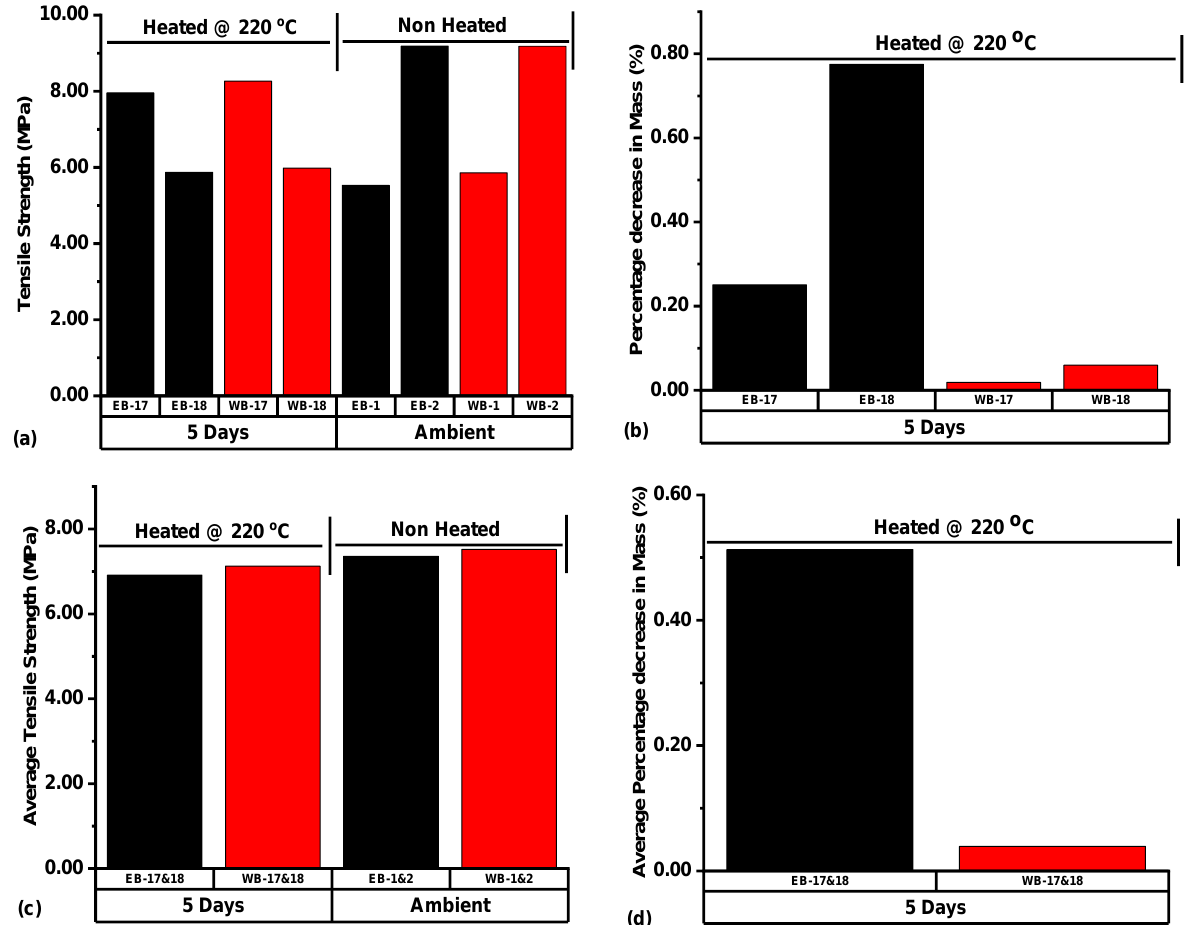
Figure 20. ( a ) Tensile strength, ( b ) Percentage decrease in mass, ( c ) Average tensile strength (ATS), and ( d ) Average percentage decrease in mass (APDM) resulting from samples subjected to different treatment conditions prior to BITS testing. Notes contained in Figure 14 still apply.